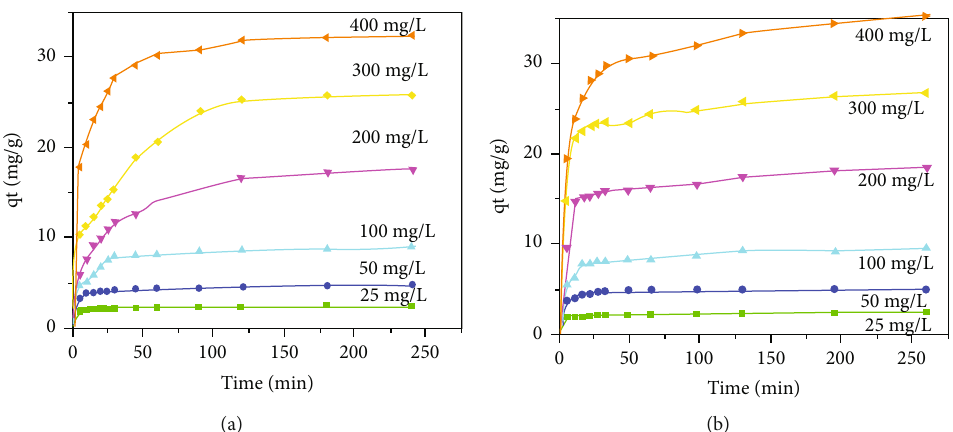
Figure 8: E ff ect of concentration and contact time of Red 2BN on (a) JPAC adsorption and (b) JPAC/TiO g, pH = 6 : 5 (solution pH), and T = 303 K).